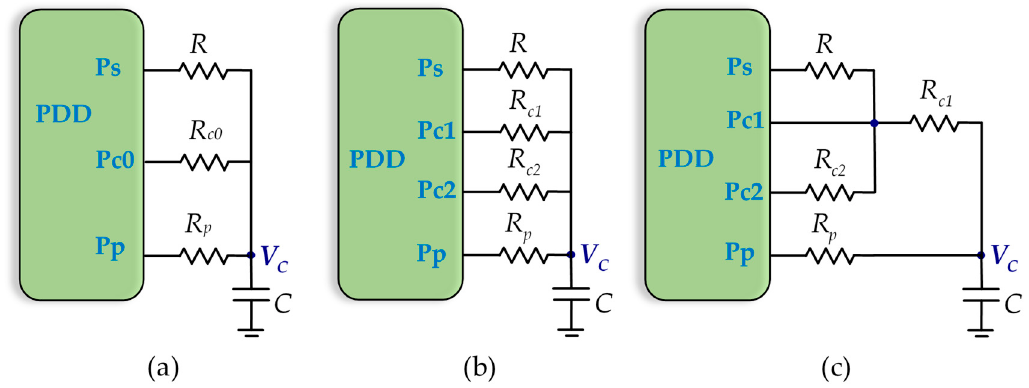
Figure 1. Different types of direct interface circuits (DICs): ( a ) single-point calibration method (SPCM); ( b ) two-point calibration method (TPCM); ( c ) three-signal calibration method (TSCM).